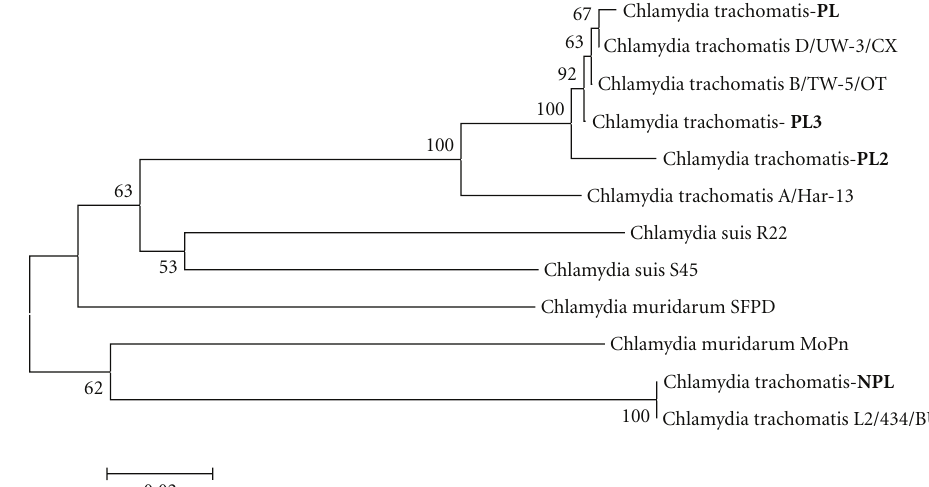
Figure 1: Dendrogram resulted from phylogenetic analysis of middle fragment of 16S–23S rRNA genes and 23S rRNA area of Chlamydia strains I segment by means of Neighbour-Joining method with execution of Bootstrap Test of Phylogeny (1000 repetitions), p -distance model demonstrating position of Chlamydia trachomatis strains being under investigation (PL: plasmid strain released from monkeys, PL2: plasmid strain released from humans, and PL3: reference strain and NPL: nonplasmid strain released from monkeys).